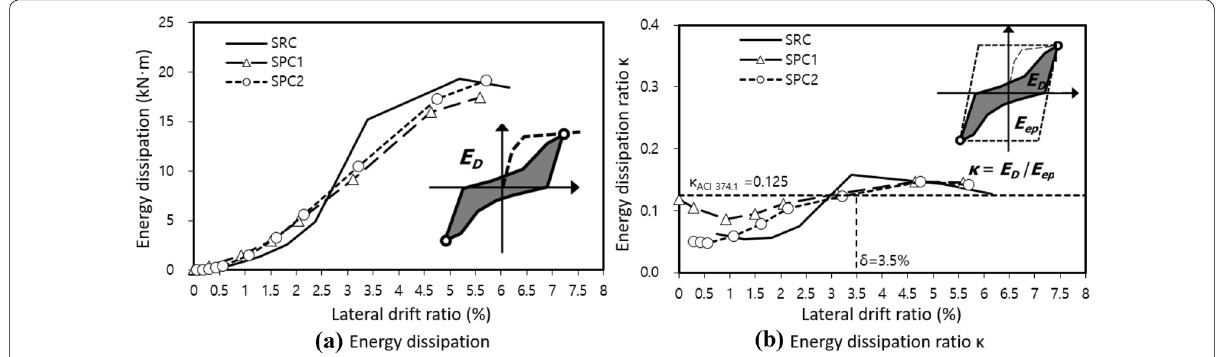
Fig. 17 Energy dissipation capacity of specimens under cyclic lateral